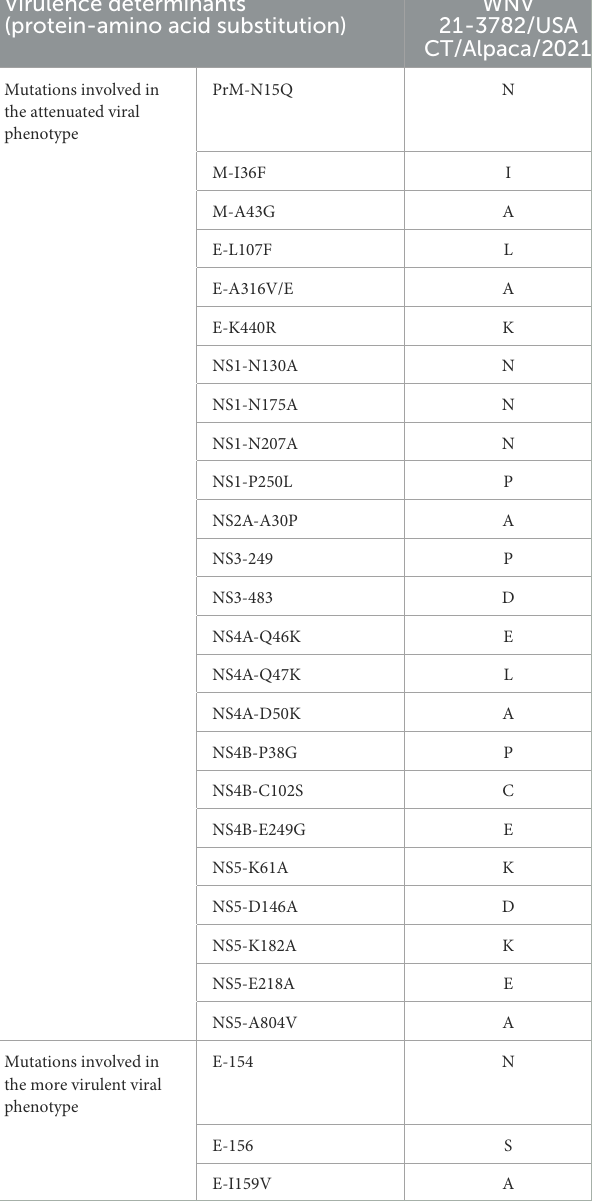
TABLE 4 Amino acid substitutions of WNV 21-3957/USA CT/Crow/2021 virus in virulence determinants in the WNV genome found in avian host. Virulence determinants (protein-amino acid